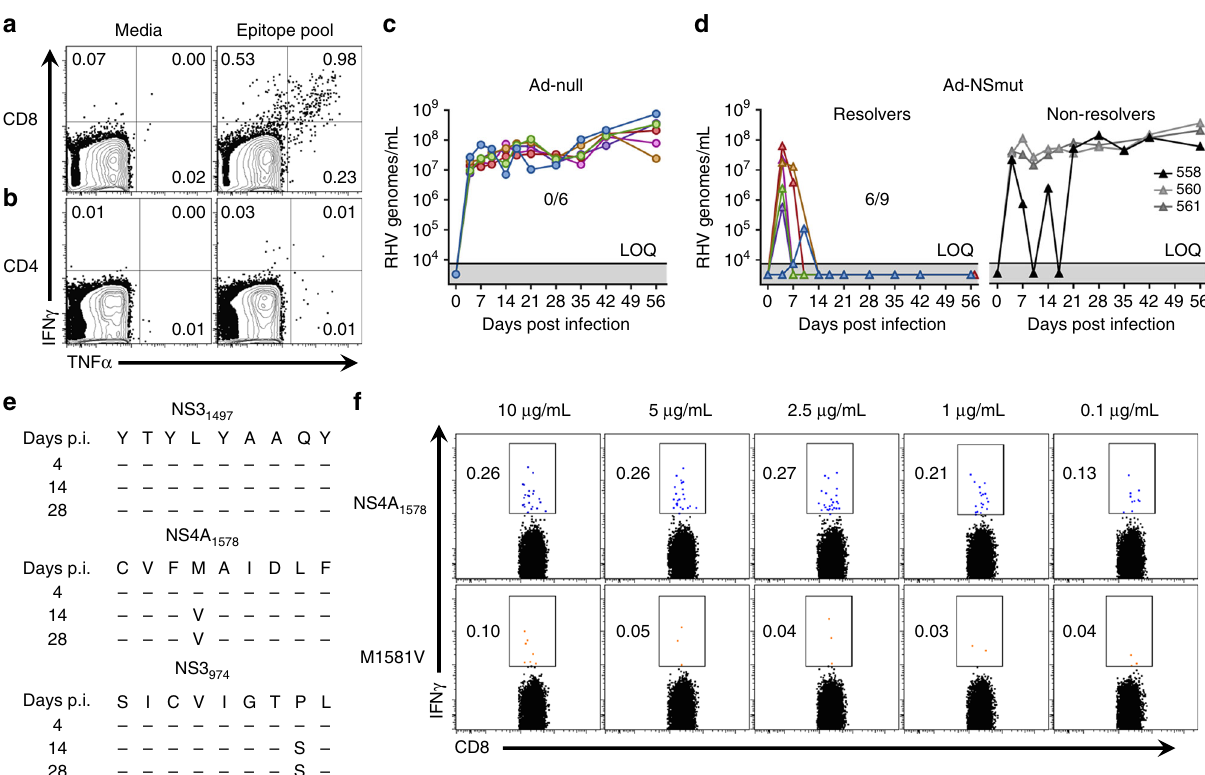
Fig. 3 T cell immunization confers partial protection against RHV infection. Lewis rats were injected intramuscularly with 5 × 10 8 ifu Ad-NSmut or empty control vector (Ad-null). After 3 weeks, rats were challenged intravenously with 10 6 genomes RHV and analyzed for infection and viral evolution. a , b Representative fl ow plots of intrahepatic cytokine production in CD8 + a and CD4 + b T cells 2 weeks after vaccination. Cells were stimulated for 5-h with a pool of MHC class I and II epitopes (5 µ g/mL). Numbers shown indicate frequency of cytokine positive cells. c , d Replication kinetics and infection outcome in c Ad-null or d Ad-NSmut immunized rats. Solid line with shading below indicates limit of quanti fi cation (LOQ) of RT-PCR. e Evolution of MHC class I epitopes in rat 558. The NS3 974 epitope was putatively identi fi ed by sequencing analysis and subsequently con fi rmed/mapped by cytokine response assay. f Flow cytometric analysis of intracellular IFN γ production by CD8 + T cells in immune splenocytes after stimulation with intact NS4 1578 epitope (top row) or peptide containing the M1581V mutation (bottom row). Cells were stimulated for 5-h with decreasing amounts of peptide as shown. Numbers shown indicate frequency of IFN γ + cells within CD8 + T cell